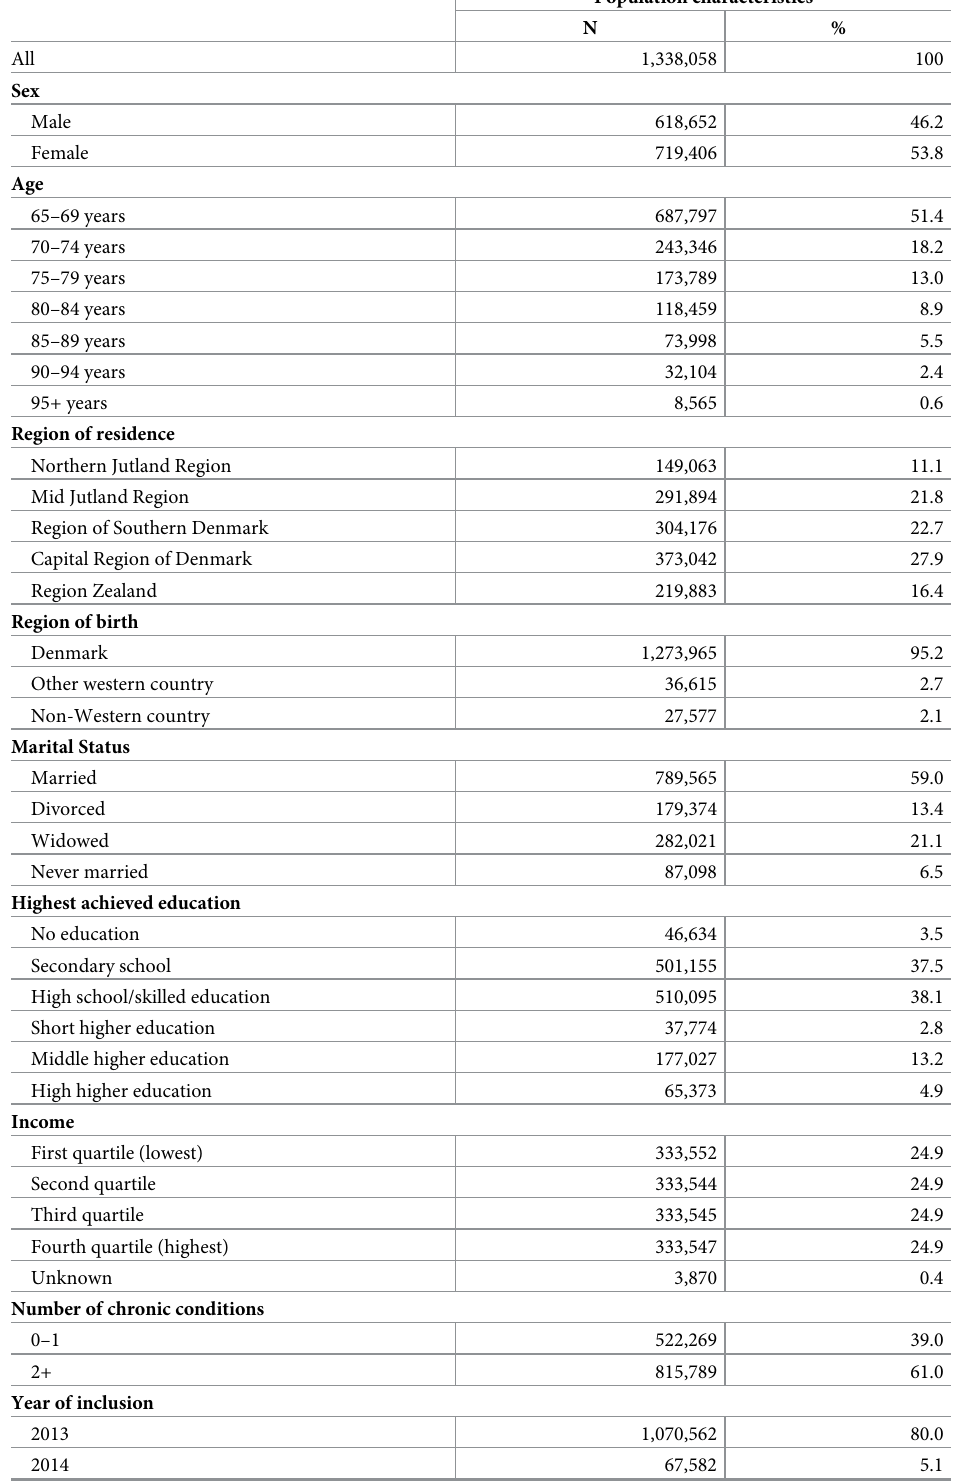
Table 1. Population characteristics at time of